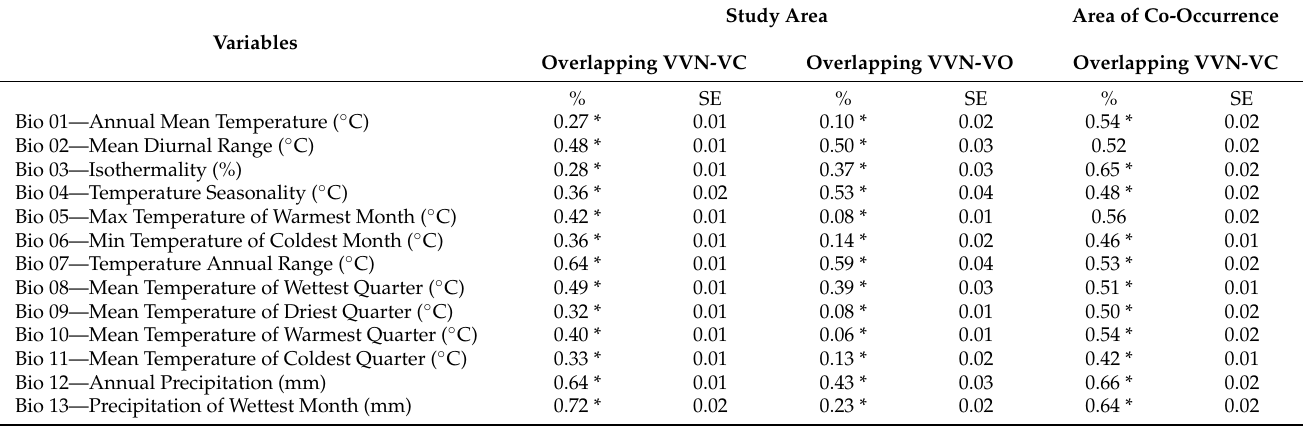
Table 1. Overlapping of the density functions among species in the study area ( Vespa velutina nigrithorax versus, respectively, V. crabro and V. orientalis ) and in the areas of co-occurrence ( V. v. nigrithorax versus V. crabro ). For each variable, the percentage of overlapping and the standard error (SE) of the estimated overlap is reported (the mean and the standard deviation values are reported in Table